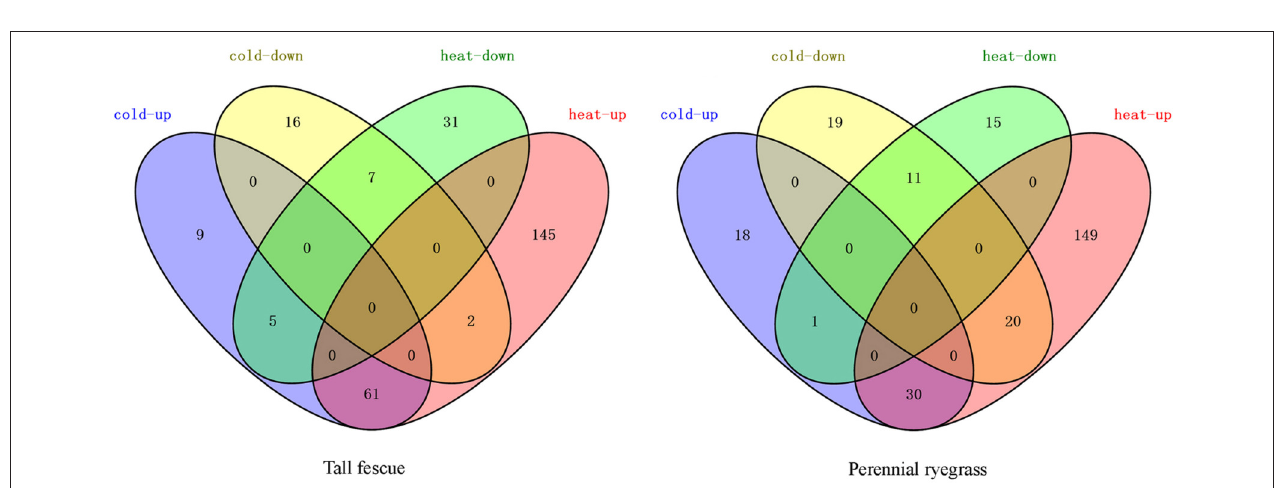
FIGURE 6 | Venn diagram of differentially expressed target genes of Hsfs in the tall fescue or perennial ryegrass under heat and cold temperature stress. Red (heat-up) represents the upregulated target transcripts under heat stress; green (heat-down) represents the downregulated target transcripts under heat stress; blue (cold-up) indicates the upregulated target transcripts under cold stress; and yellow (cold-down) represents the down-regulated target transcripts under cold